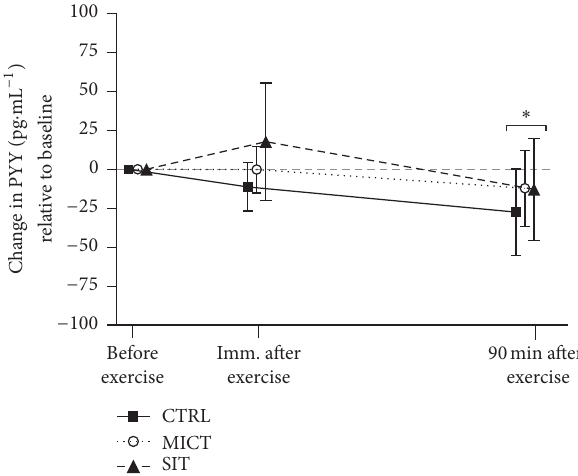
Figure 3: Changes in PYY concentrations across all time points relative to baseline for each experimental session. CTRL: control (no exercise); MICT: moderate-intensity continuous training; SIT: sprint interval training. Note . ∗ Significantly different versus before exercise ( 𝑝 = 0.016 ) and immediately after exercise ( 𝑝 = 0.013